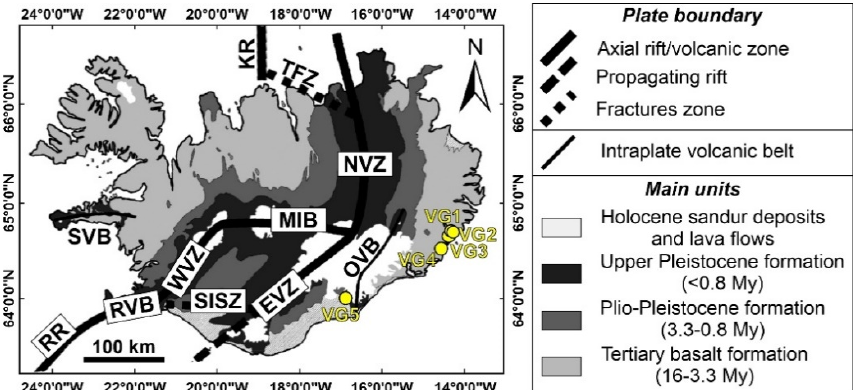
Figure 1. The main volcano-tectonic rift zones of Iceland (black lines); the distribution and age of the main geological formation is also highlighted (redrawn from Thordarson and Larsen [57]). Yellow circles locate the outcrops illustrated in this work, all belonging to the Tertiary basalt formation.